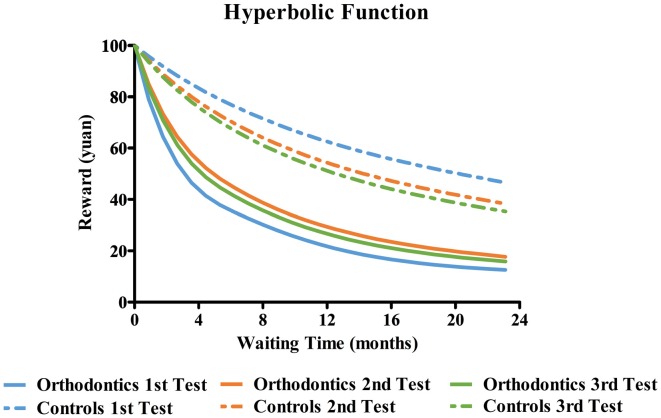
Waiting time and Hyperbolic Function. Fitted hyperbolic functions were plotted for a fixed reward of 100 yuan for both groups according to their k values across three sections. For the purposes of graphical presentation, the unit of waiting time was converted from “days” to “months”. As is illustrated, the orthodontic patients showed steeper discount function compared to control participants across all the three sections.